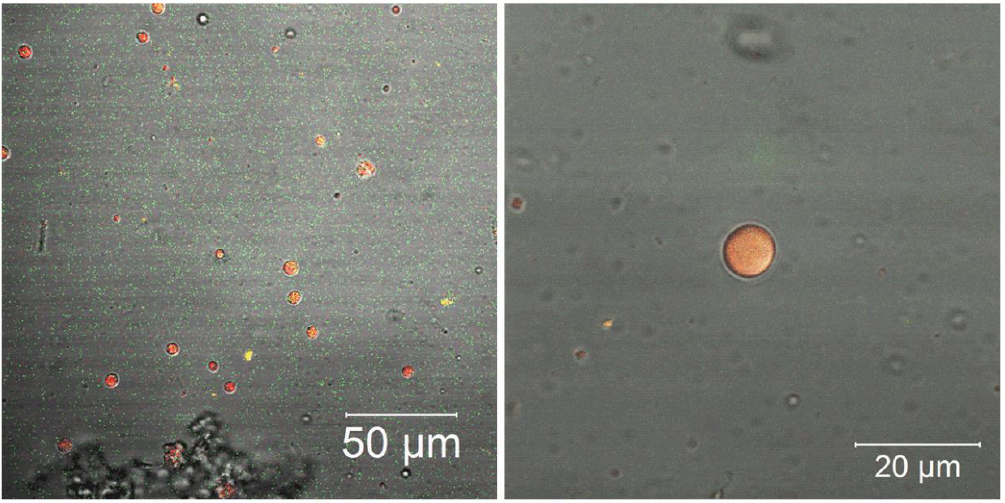
Figure 6. Confocal microscopy images of the particles from loaded system (P 1000 ).